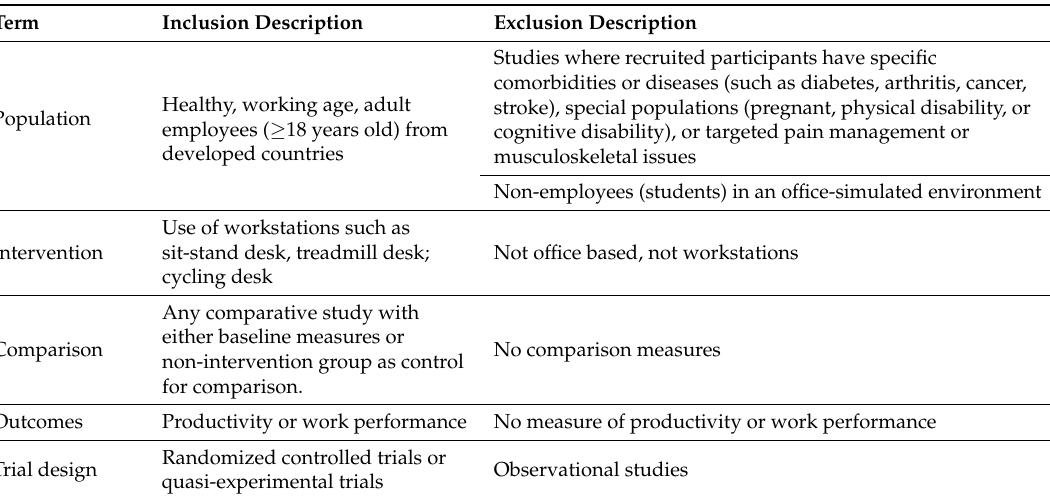
Table 1. Inclusion and exclusion